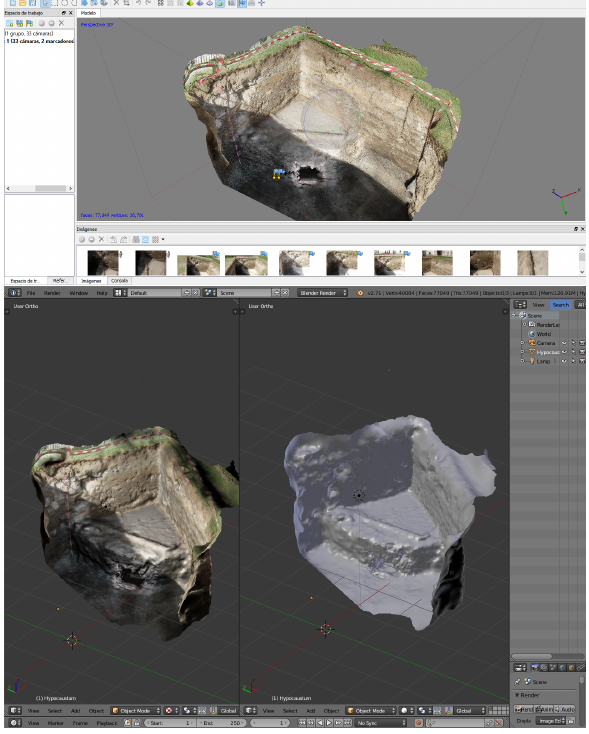
Figure 5: The exterior side of the hypocaustum reconstructed in Agisoft PhotoScan (top) and the same 3D model imported in Blender